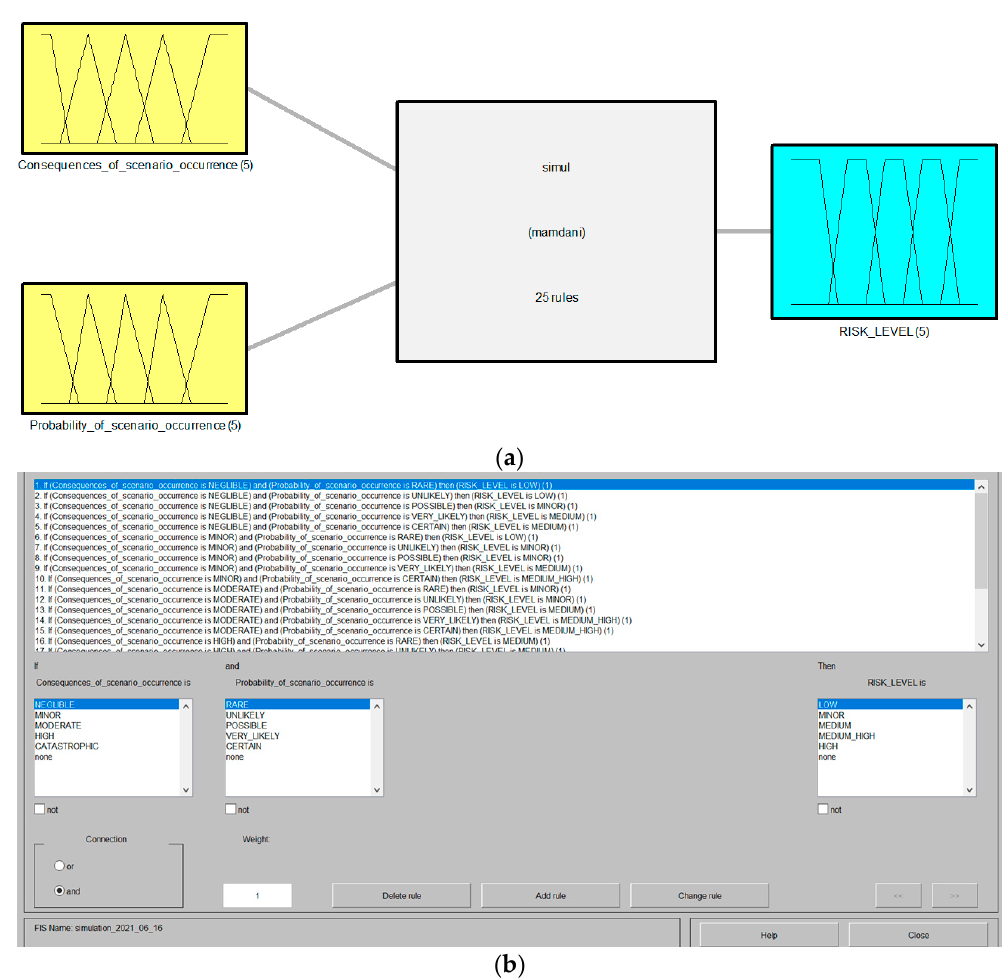
Figure 7. Membership functions: ( a ) probability of the scenario occurrence; ( b ) consequences of the scenario occurrence; ( c ) risk level.